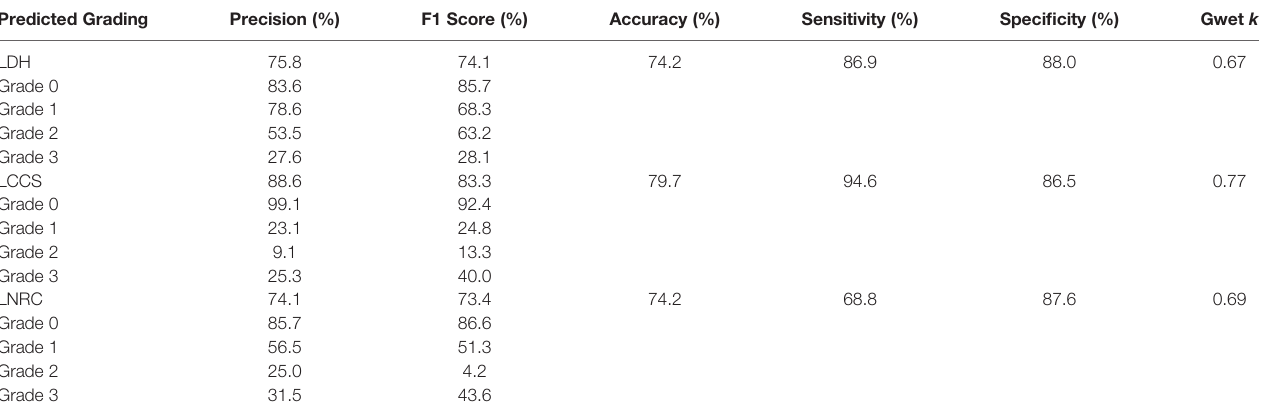
LDH, lumbar disc herniation; LCCS, lumbar central canal stenosis; LNRC, lumbar nerve roots